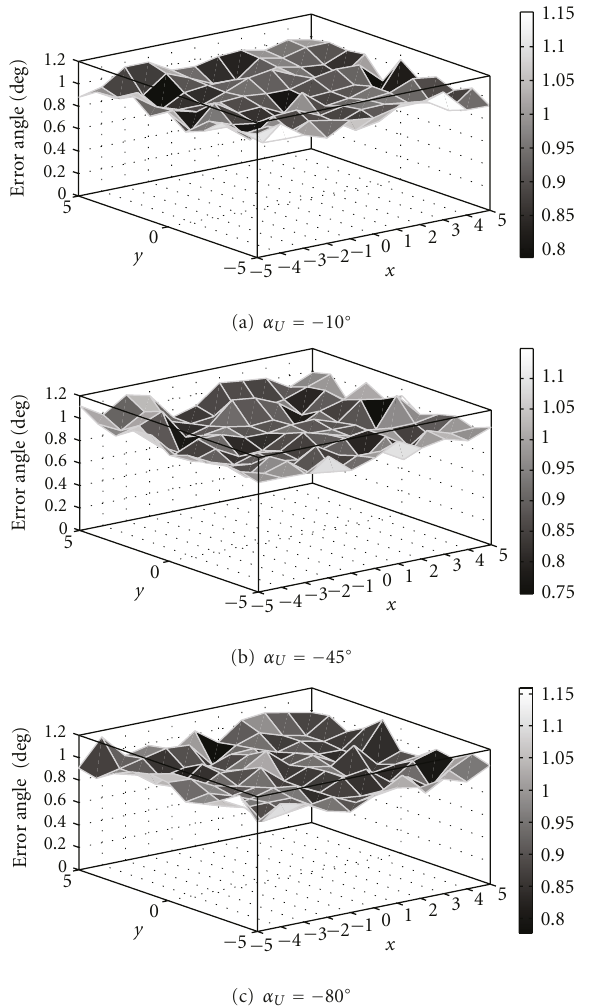
Figure 6: RMS azimuth estimation error in FLAOA positioning using the closed-form